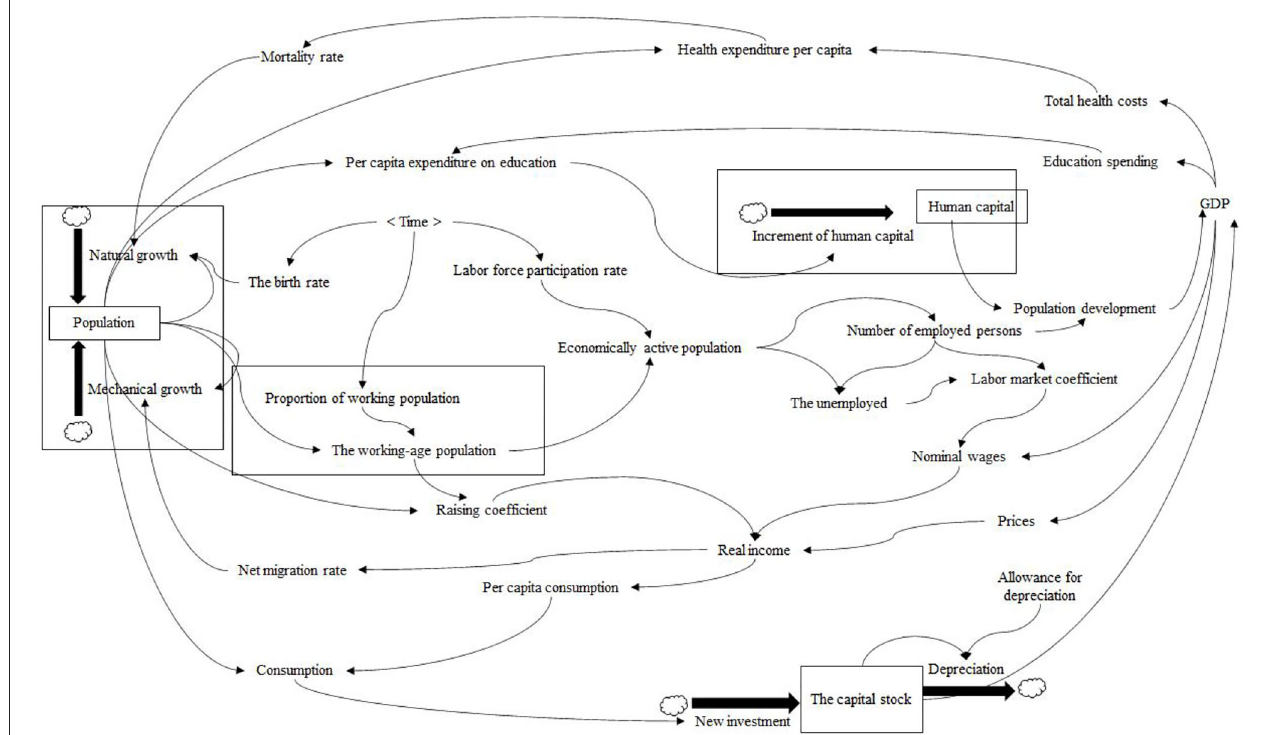
FIGURE 1 | System dynamics model of population development and economic